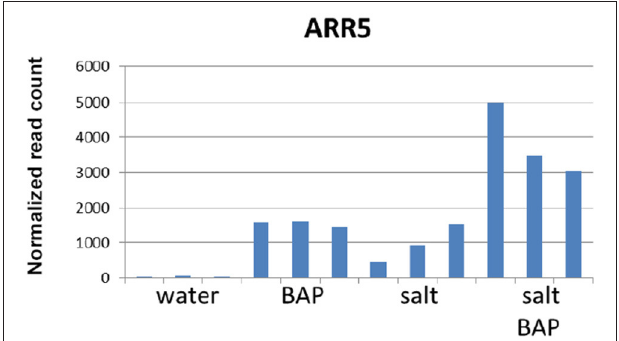
FIGURE 10 | Effect of CK on the differential expression of ARR5 under salinity stress. Arabidopsis w.t. plants were grown for 30 days in optimal conditions and then leaves were detached and exposed to10 µ m BAP, 120mM NaCl or salt plus BAP treatments for 24h. Controls were detached leaves in water. Samples (3 for each treatment) were collected from controls and stressed leaves.